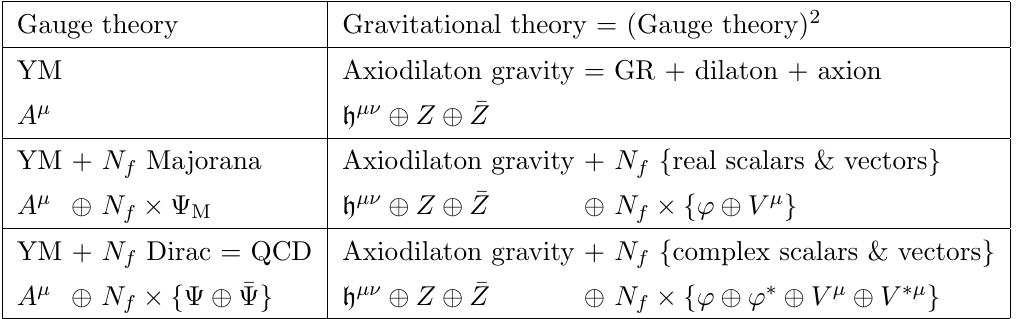
Table 1 . Field content for pure Yang-Mills theory, self-conjugate QCD [74] and conventional QCD and their respective double